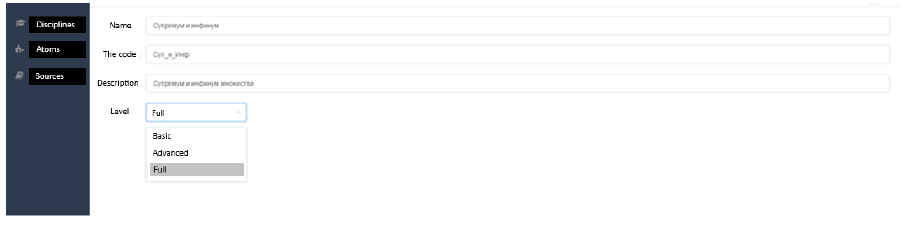
Fig. 2. Atom’s example.